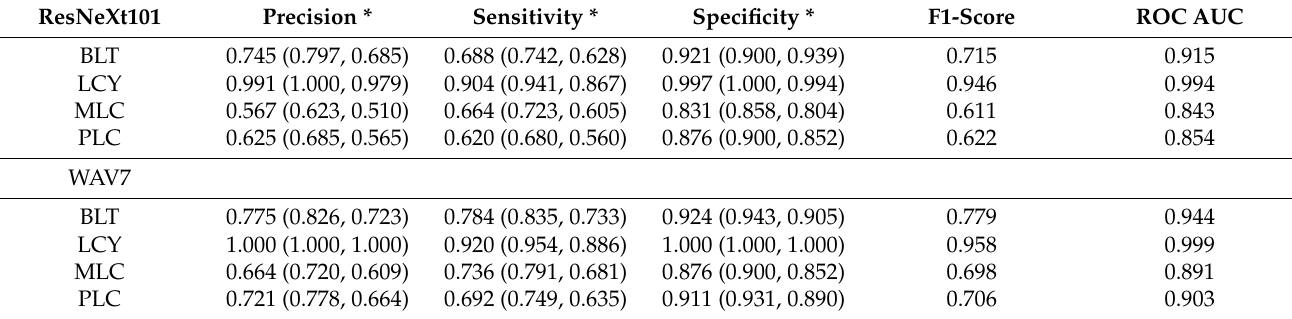
Table 10. Metrics of 4 different liver masses for ResNeXt101, the model with the highest accuracy among 16 CNNs, and WAV7 (top7 was used for weighted average voting), the model with the highest accuracy among all models of ensemble learning. BLT: benign liver tumor, LCY: liver cyst, MLC: metastatic liver cancer, PLC: primary liver